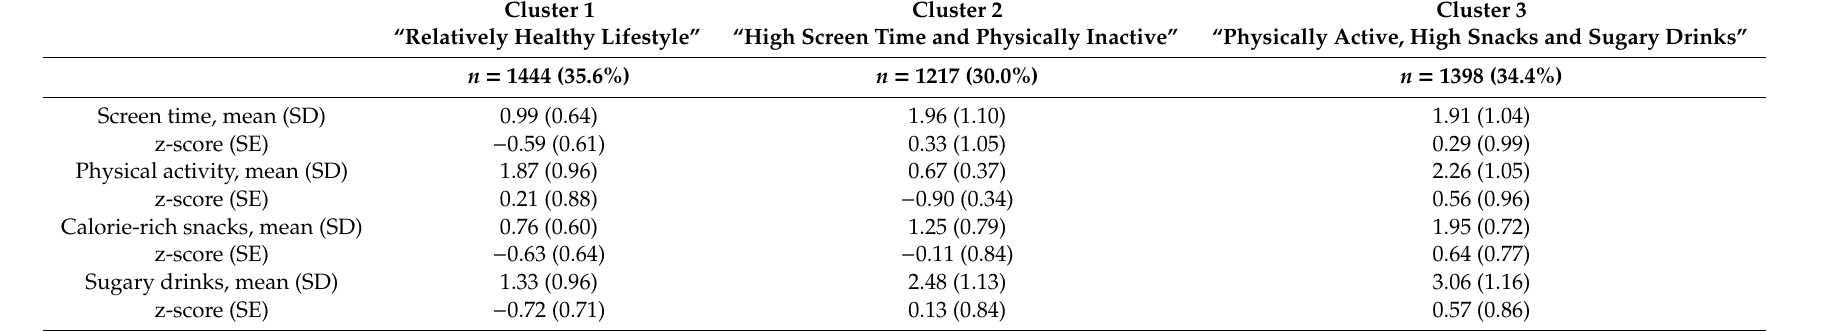
The table is based on a non-imputed